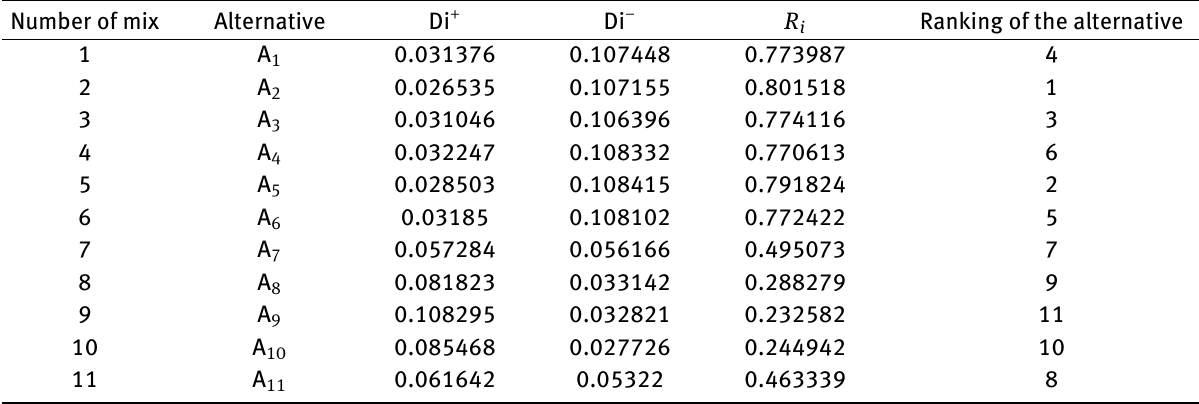
Table 19: The distance to the positive and negative ideal reference point (Di + and Di − ), Relative closeness coeflcient ( R i ) to the ideal reference point and the ranking for each